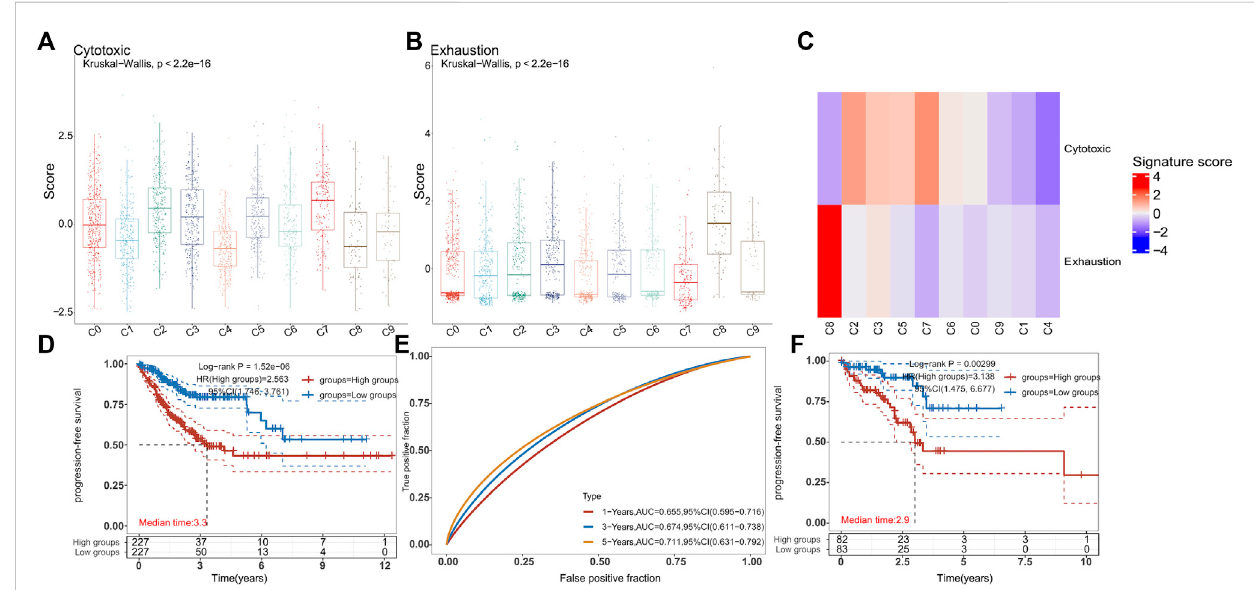
FIGURE 6 Combinationtreatmentiscon fi rmedtoincreasethePFSofpatientswithdigestivetractmalignancybyregulatingtheCD8 + T-cellsub-cluster (A – C) . In the scRNA-seq data, boxplots and heatmaps showed the cytotoxicity and exhaustion signature scores for each CD8 + T-cell cluster. The VISION method was used to calculate signature scores for each cell cluster (two-sided Wilcoxon test) (D) . KM survival curves of TCGA-CRC patients ( n = 455) grouped by theaveraged expressionof the COX model (withthe median value as thethreshold).HR (high expression) represents thehazard ratio of the low-expression sample relative to the high-expression sample. HR (95% Cl) represents the median survival time (LT50) for different groups. The blue line represents the low expression of the average expression of the COX model, and the red line represents the high expression (E) . The ROC model was usedtotesttheaccuratesurvivalpredictionfor1 year,3 years,and 5years.ThehigherAUCscorecorrespondedtohigherpredictivepower (F) .Therectal cancer data and clinical information were downloaded from TCGA database ( n = 165). KM survival curves (F) were the same as (E)